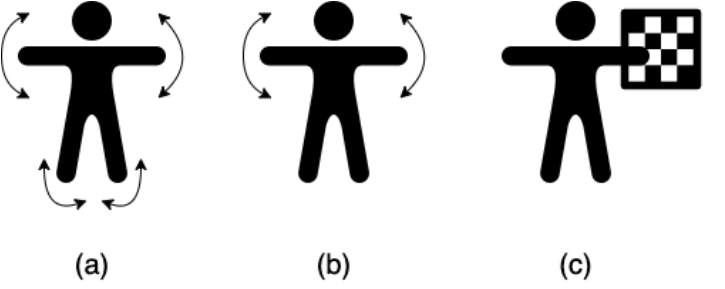
Figure 8. Three types of movements were recorded in each setup: ( a ) Moving all body parts, ( b ) Moving hands, and ( c ) Holding and moving a checkerboard.